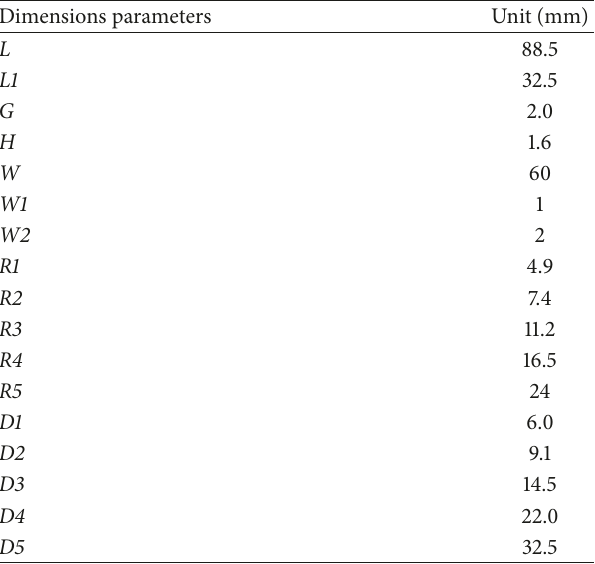
Table 1: Dimensions of the proposed